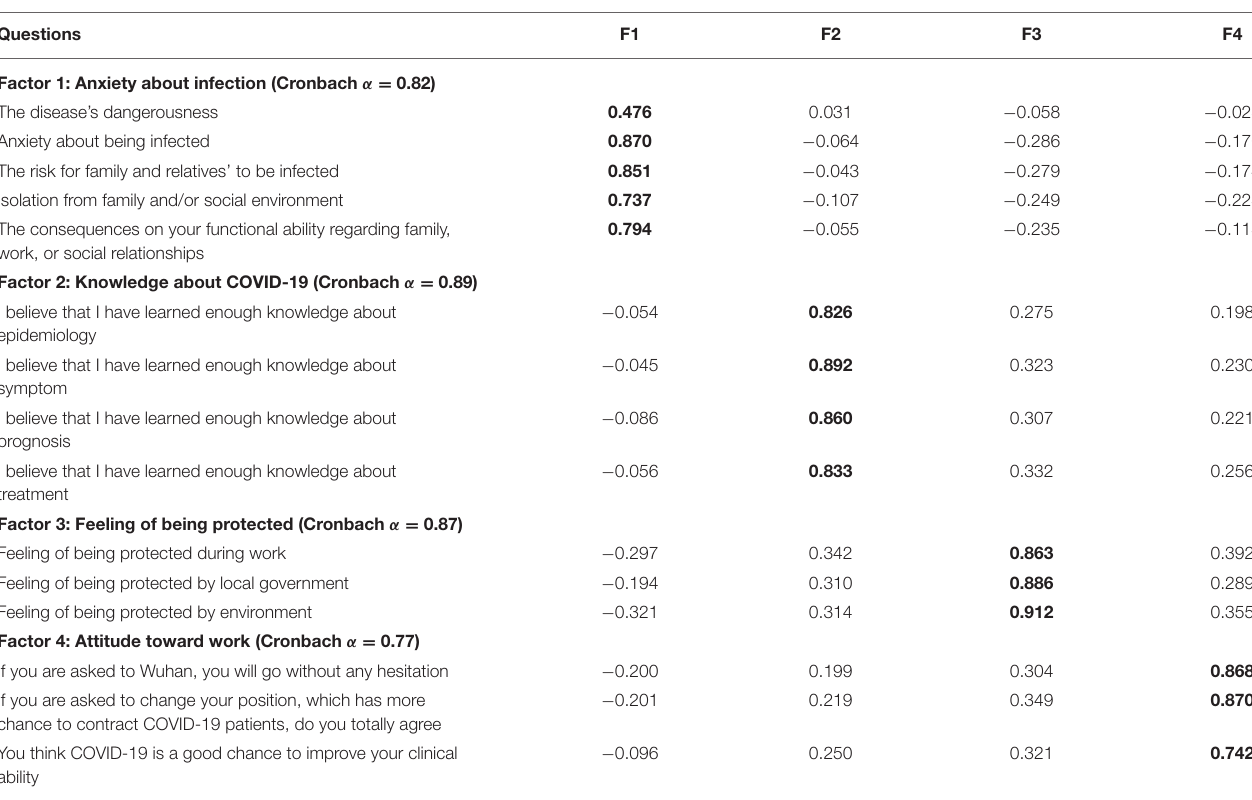
TABLE 2 | Factor analysis of the 15 stress-related